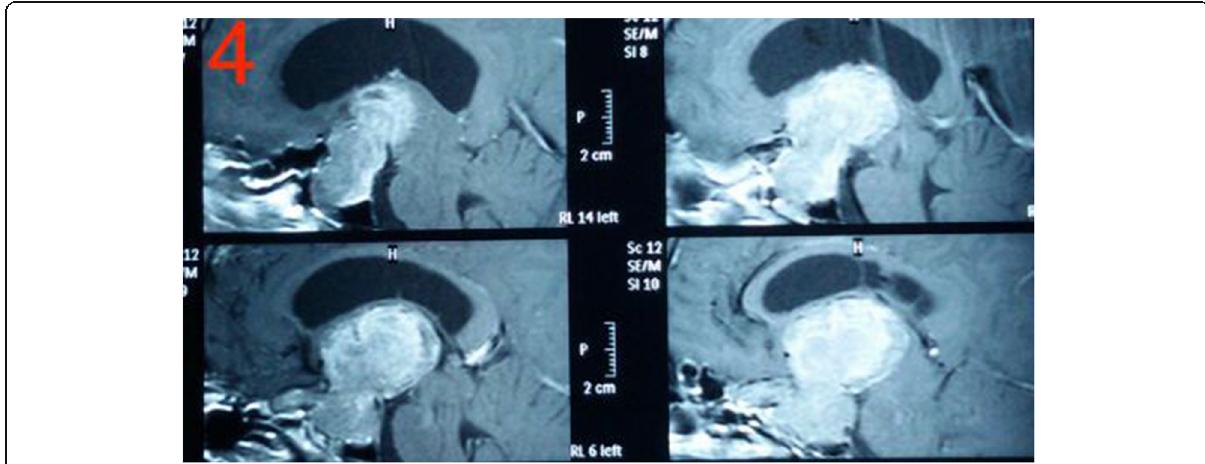
Fig. 4 MRI brain T1WI with contrast showing a case with large suprasellar extension obliterating the third